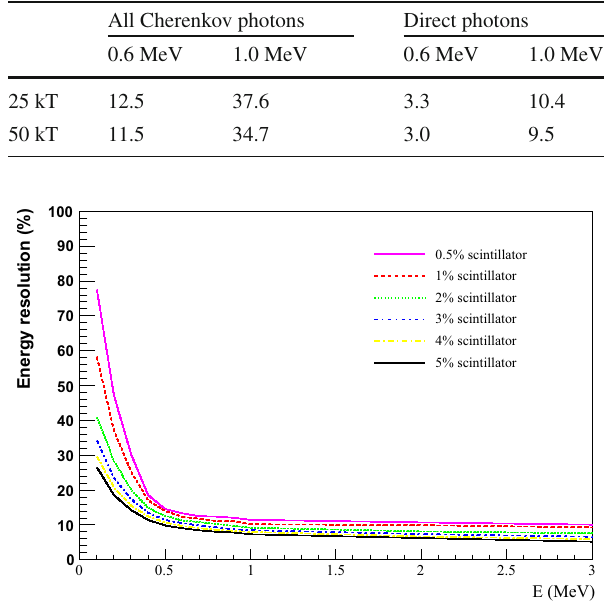
Fig. 5 Energyresolutionasafunctionofenergyforvariousscintillator fractions for a 50 kT